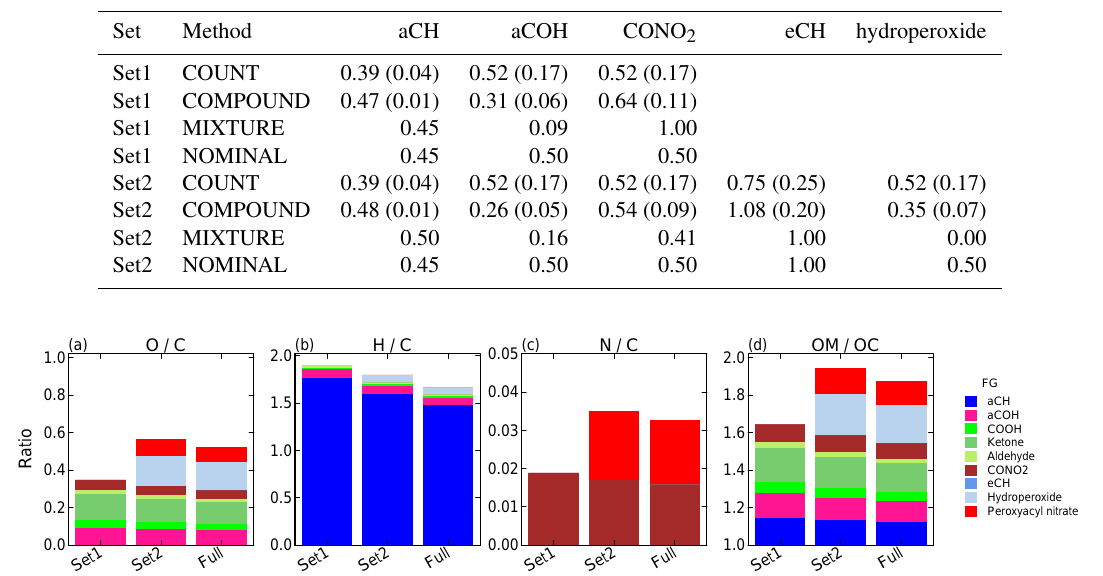
Figure 6. SOA properties for APIN simulation at t max SOA . Atomic ratios ( n ∗ a /n ∗ ratios shown in panel (d) are in mass units. The abundance of carbon used for normalization is defined by the detectable carbon for each set of FGs (Sect. 2.3), which can lead to estimated ratios with Set1 or Set2 to exceed the Full case.